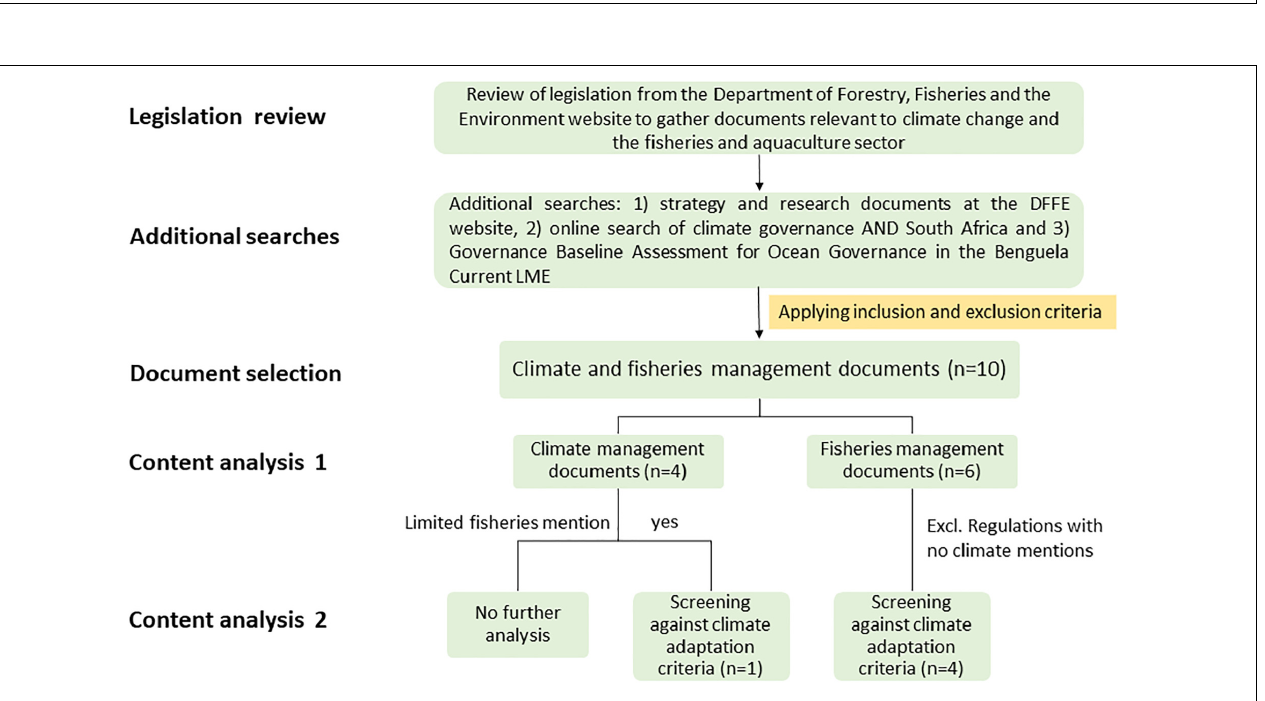
FIGURE 2 | Map of South Africa including provincial boundaries. The coastal provinces listed in Provincial and Local Institutions are highlighted in light blue.